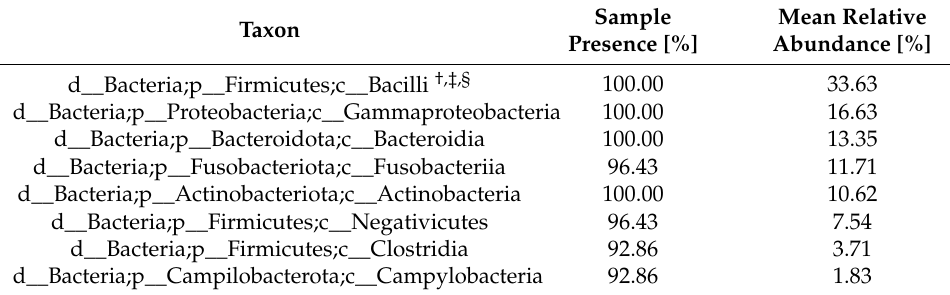
Table 3. Dominant classes among swab samples, in consecutive order.